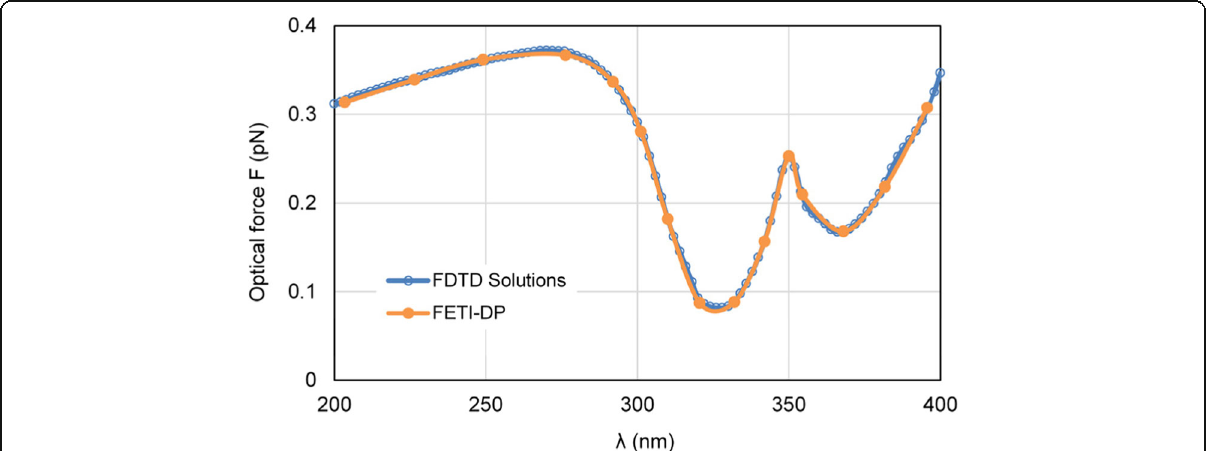
Fig. 4 Results of the optical forces exerted on the silver nanocapsule, varying with the wavelength λ of incident light, including the results of the FETI-DP and the commercial software FDTD solutions